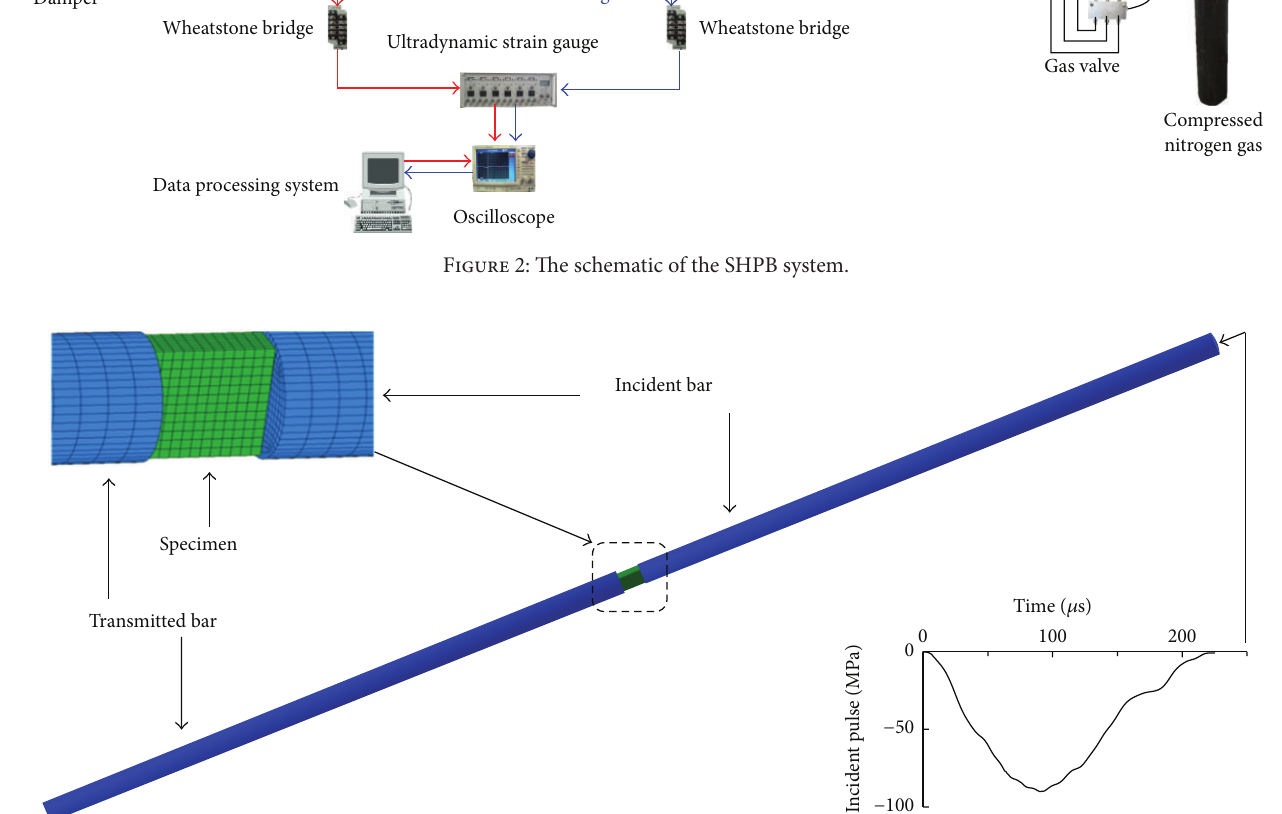
Figure 3: The model of SHPB device with incident pulse.